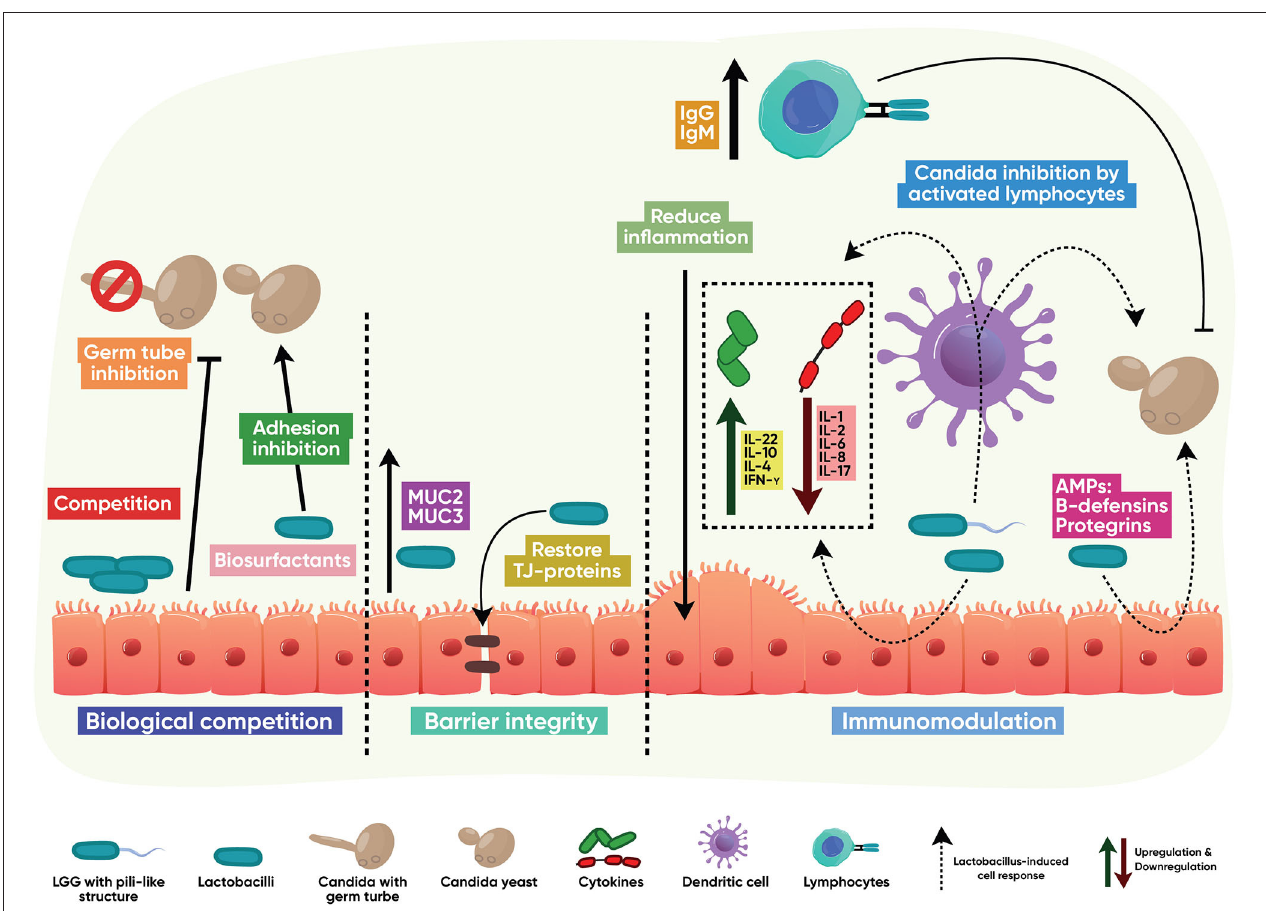
FIGURE 2 | Indirect antifungal modes of action. Lactobacillus interacts with the host to stimulate protective, antifungal functions. These mainly result from competition with Candida in binding to mucus membrane glycoconjugates; strengthening the mucosal barrier through induction of mucins and positive regulation of tight junction proteins; activation of T and B cell immune responses; downregulation of host-destructive inflammation; and induction of innate epithelial antimicrobial